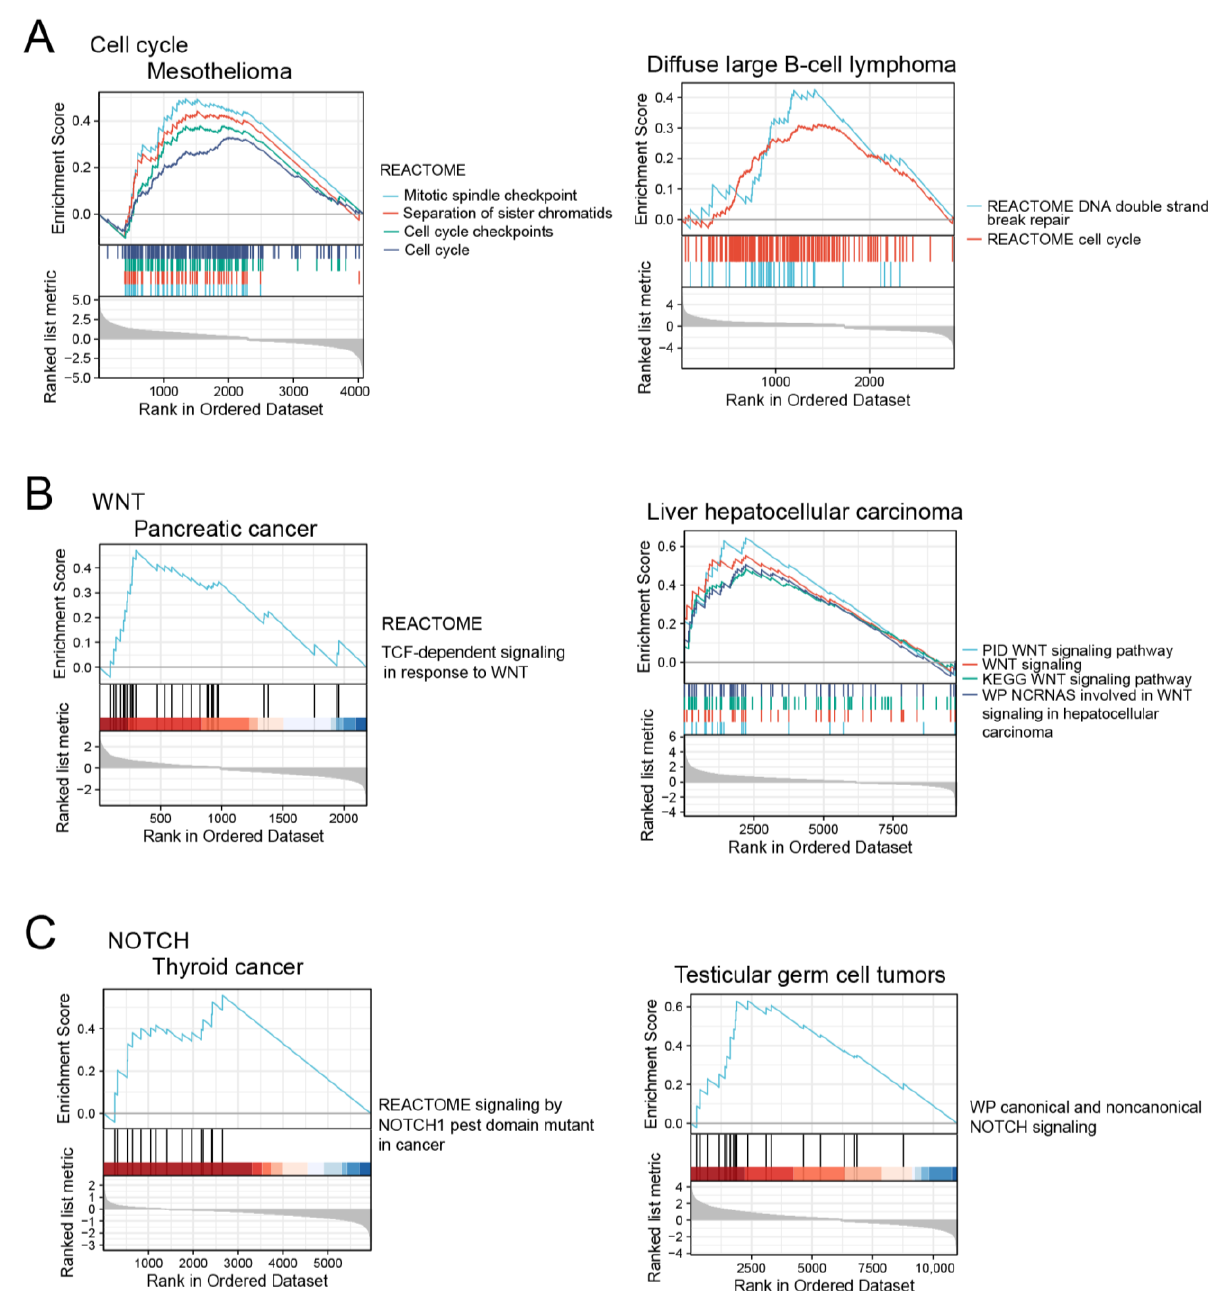
Figure 7. The activation of cell cycle ( A ), WNT ( B ), and NOTCH signaling pathways ( C ) in ERFE high tumor samples based on GSEA analysis.